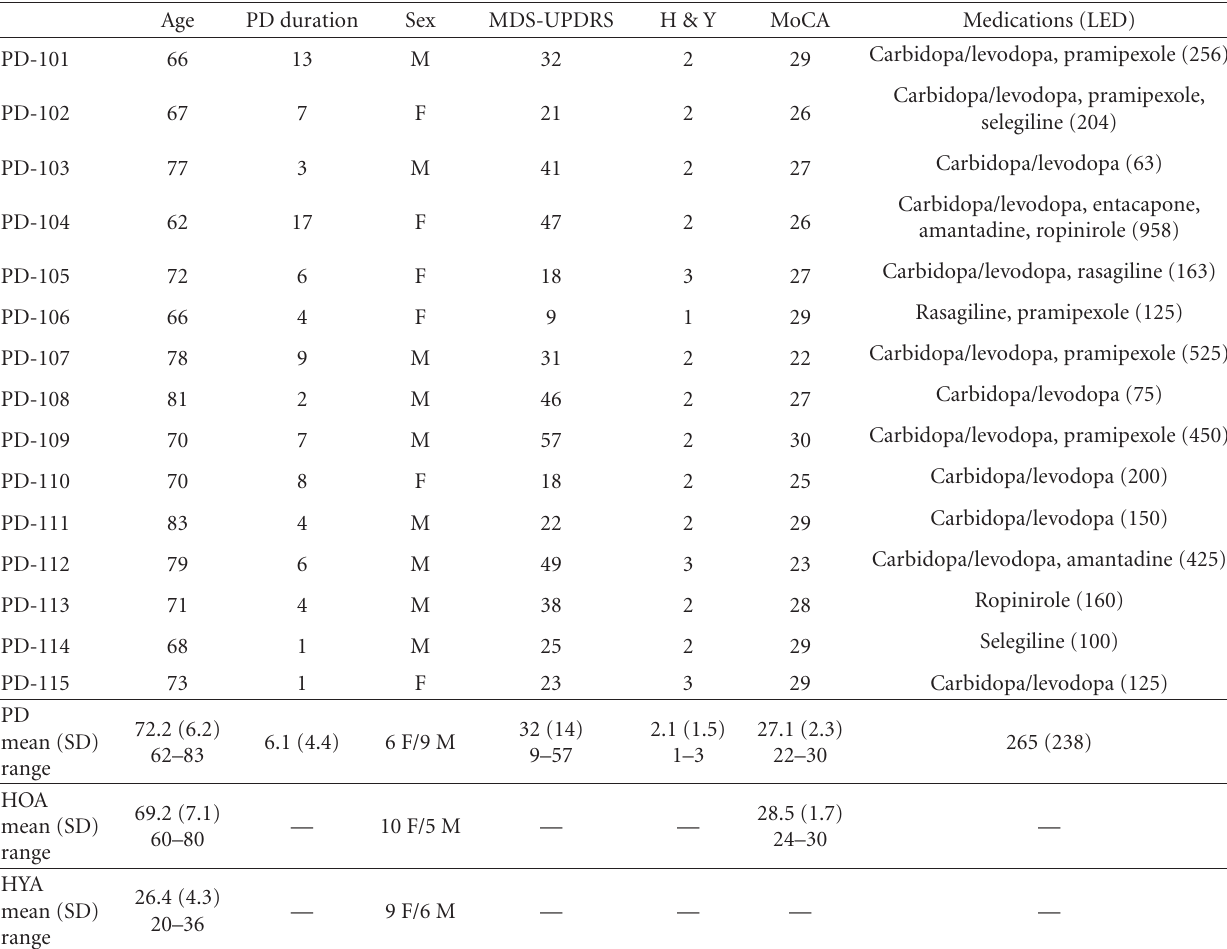
Table 1: Individual characteristics and group summary for participants with PD and summary for HOA and HYA